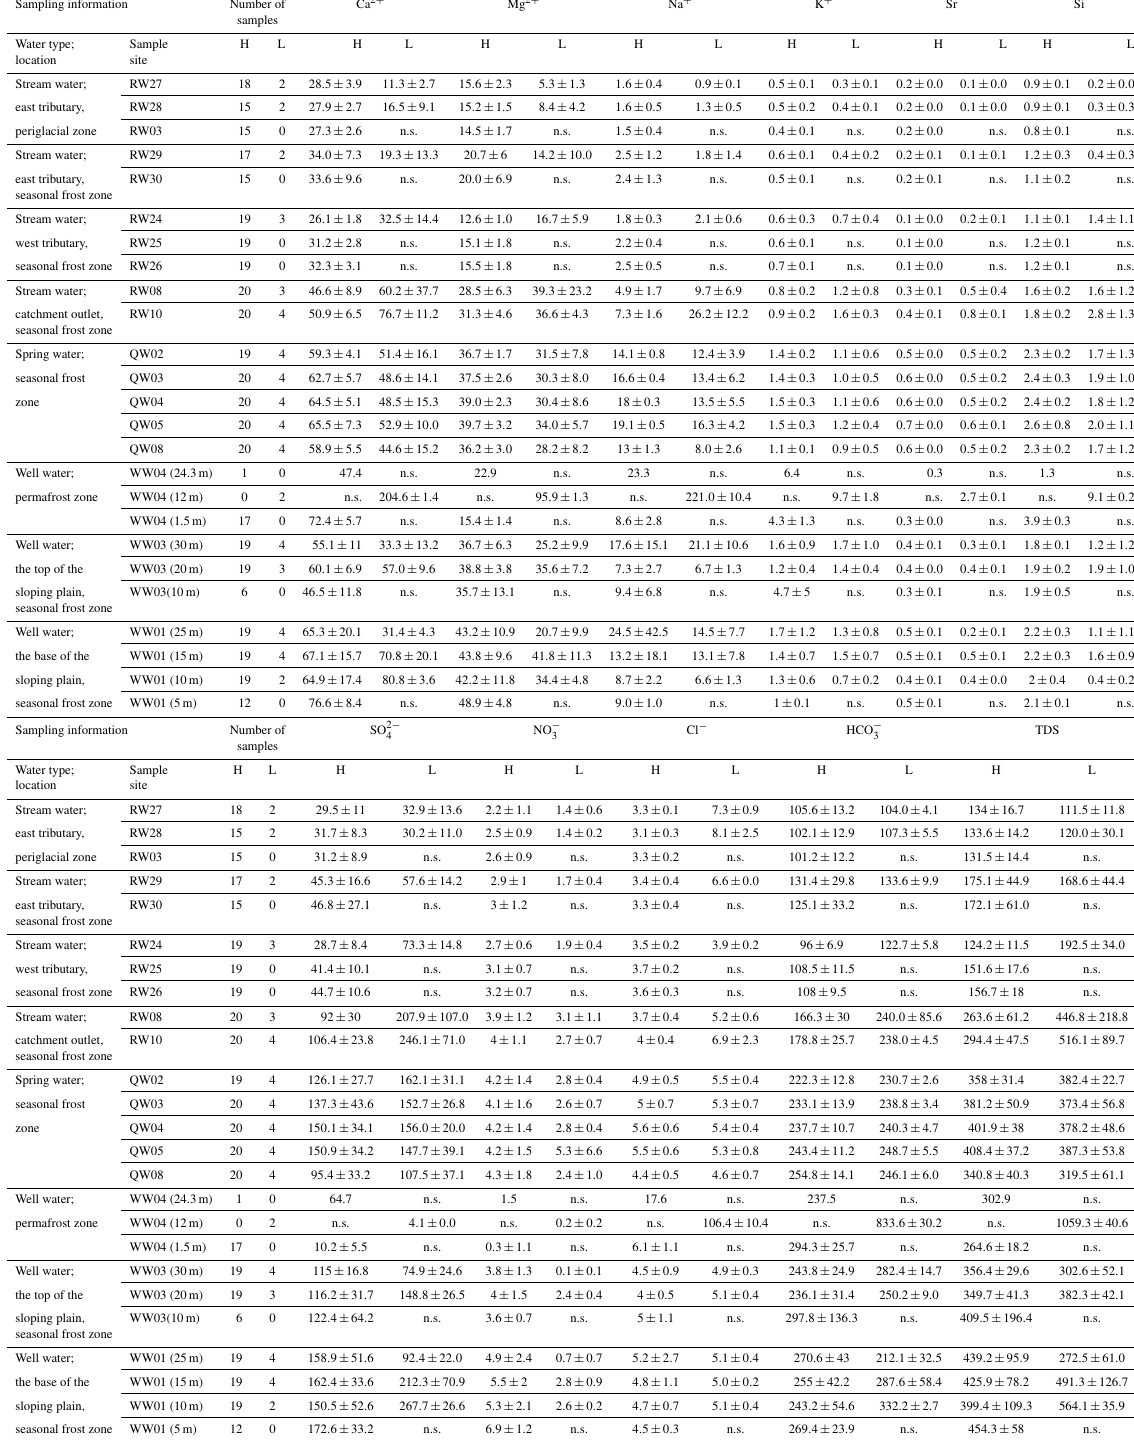
Table 1. Mean values and standard deviations ( ± SD) of major ions and Si, Sr and TDS concentrations in groundwater and stream water (in mgL − 1 ) within permafrost and seasonal frost zones. Number of samples used to calculate is also shown. All samples were collected from January 2014 to September 2015. “H” refers to high flows in the warm season, “L” refers to low flows in cold season, and “n.s.” means that no samples were